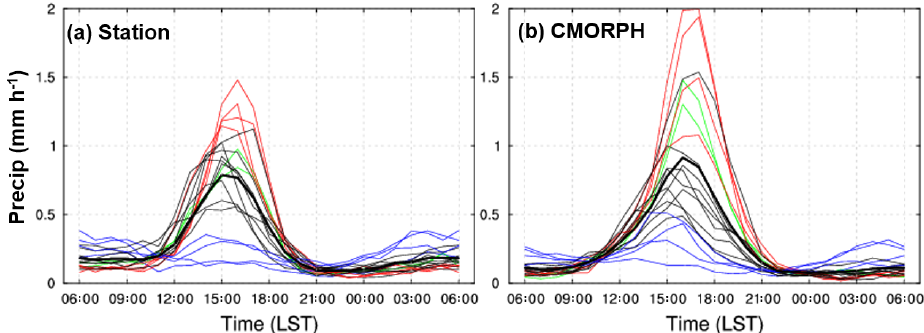
Figure 5. Average rainfall accumulations by hour in May and June (a) from rain gauges and (b) derived from CMORPH.